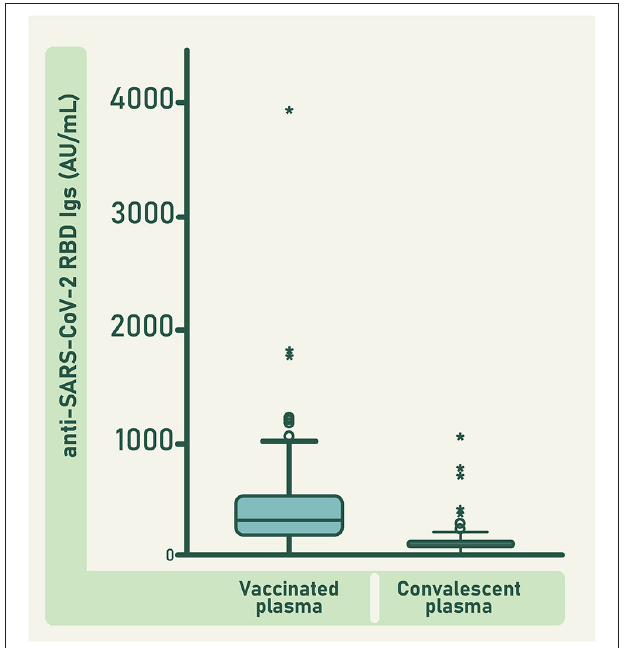
FIGURE 3 | Concentration of anti-RBD antibodies in individual units of vaccinated and convalescent plasma. Bars represent the mean value ± 95 CI. Circles represent the outlier data points and asterisks represent the extreme outlier data points. Difference between both groups was significant ( F = 57.435; d f = 1; 301; p ≤ 0.0001). units of convalescent plasma ( F = 57.435; d f = 1; 301; p ≤ 0.0001;